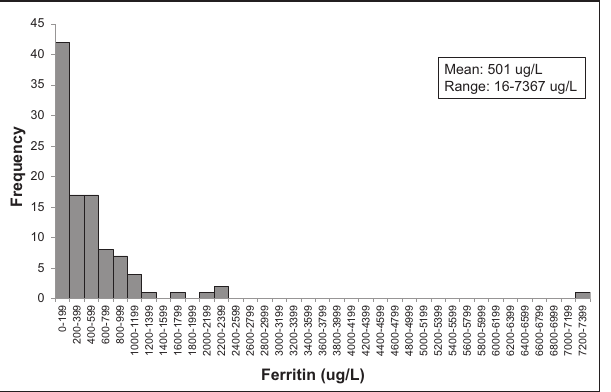
Figure 1) Histogram of ferritin levels at the time of genotyping